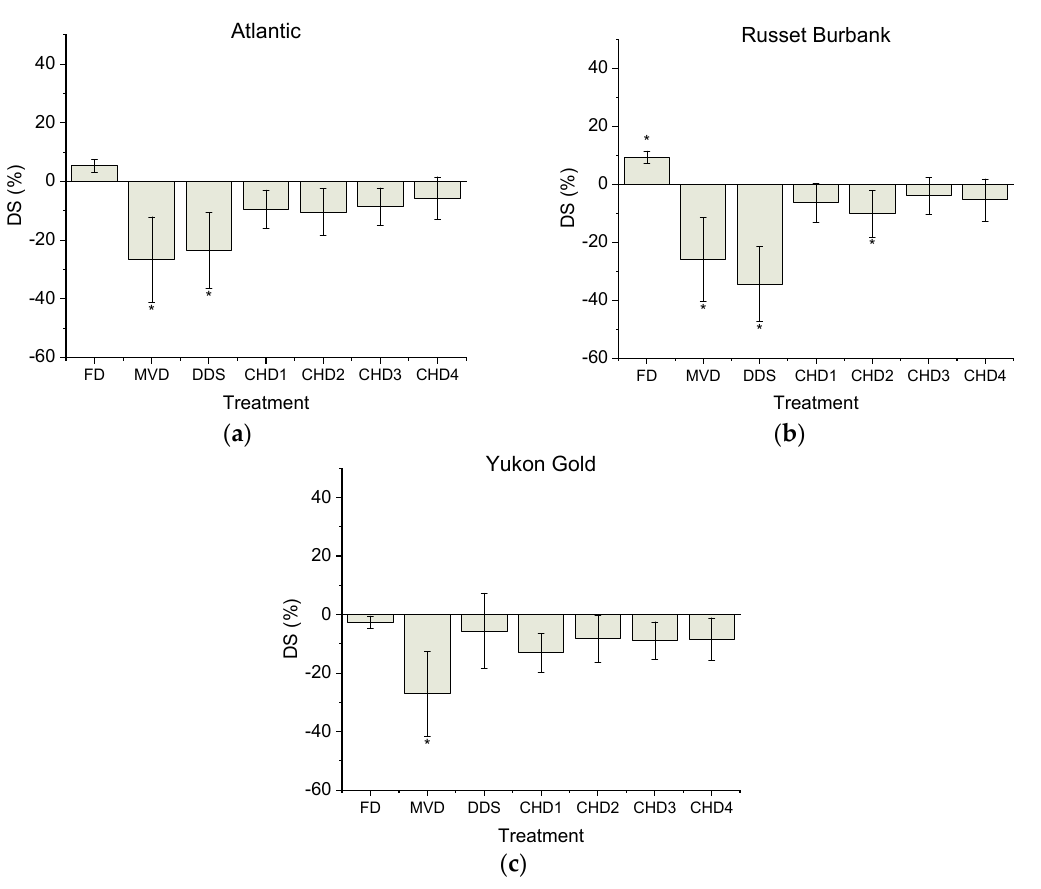
Figure 1. Digestible starch (DS) (percent difference) compared to fresh controls for Atlantic (ATL) ( a ), Russet Burbank (RB) ( b ) and Yukon Gold (YG) ( c ) potato cultivars. Baseline DS content of freshly cooked controls were 72.32 ± 3.05, 66.67 ± 0.920 and 69.98 ± 1.68 (g/100 g DW) for ALT, RB and YG respectively. Different drying treatments were assessed and compared to a fresh control using Dunnett’s test. Data is presented as mean ± SEM. For each genotype, * indicates statistically significant ( p < 0.05) difference in comparison to control (fresh).